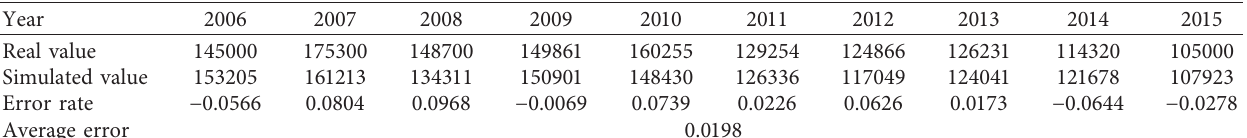
Table 1: Historical value